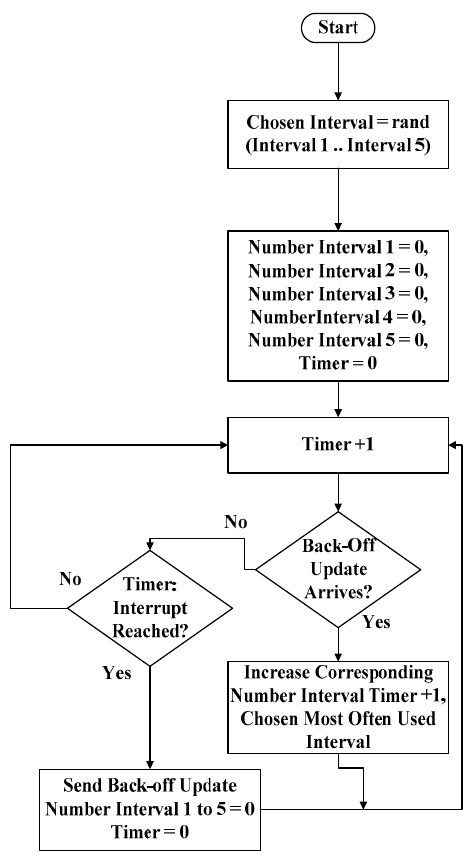
Figure 3. Back-Off Time Optimization based on the Ant Colony Optimization Algorithm (Used Interval).